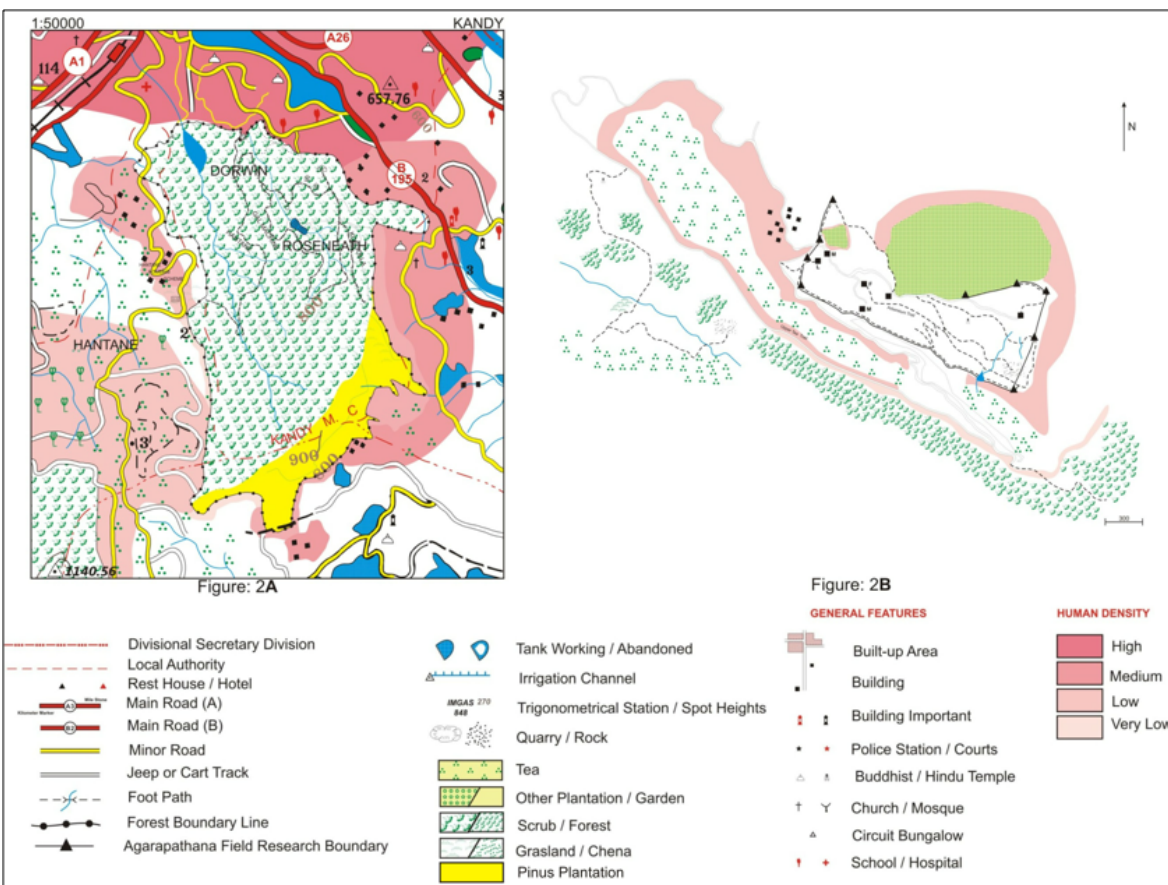
Figure 2 (a-b). Map of (a) Dunumadalawa forest reserve and (b) Agrapatana study area in context of surrounding landscape. Areas of high, medium and low human population pressure are indicated. Trails/roads used for prey index and habitat selection inside Dunumadalawa are shown but details of those interior trails/roads are not